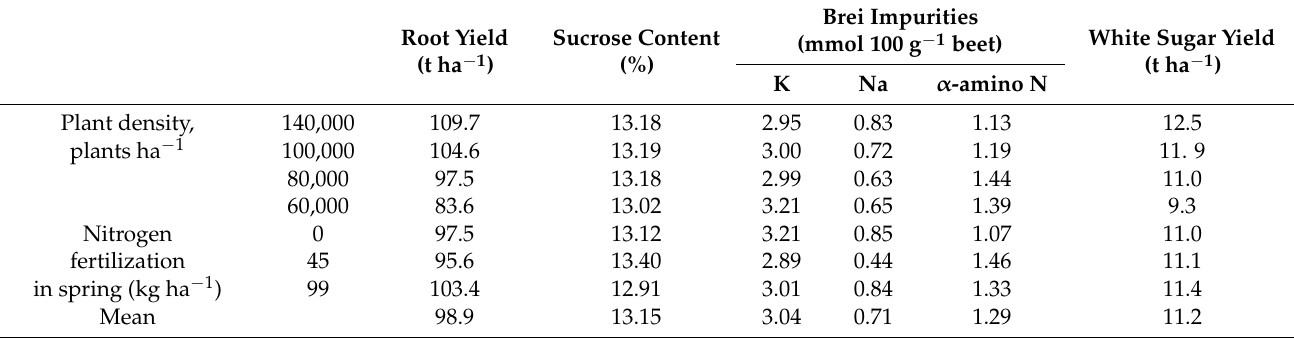
Table 3. Sugar beet root yield, quality and sugar yield as affected by different plant densities and nitrogen fertilization rate in 2014.